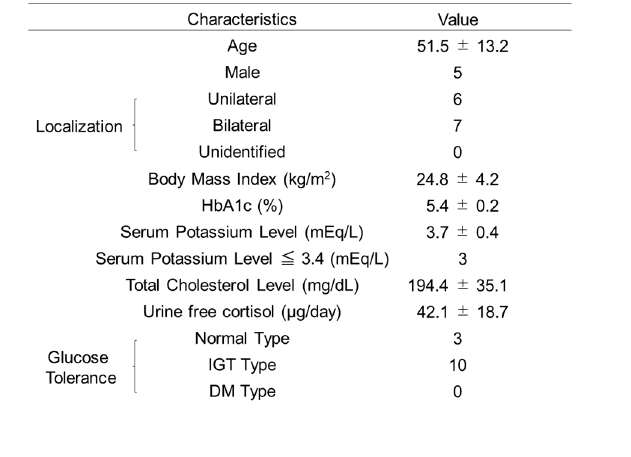
Figure 6. Baseline Characteristics of PA Patients ( n = 13).